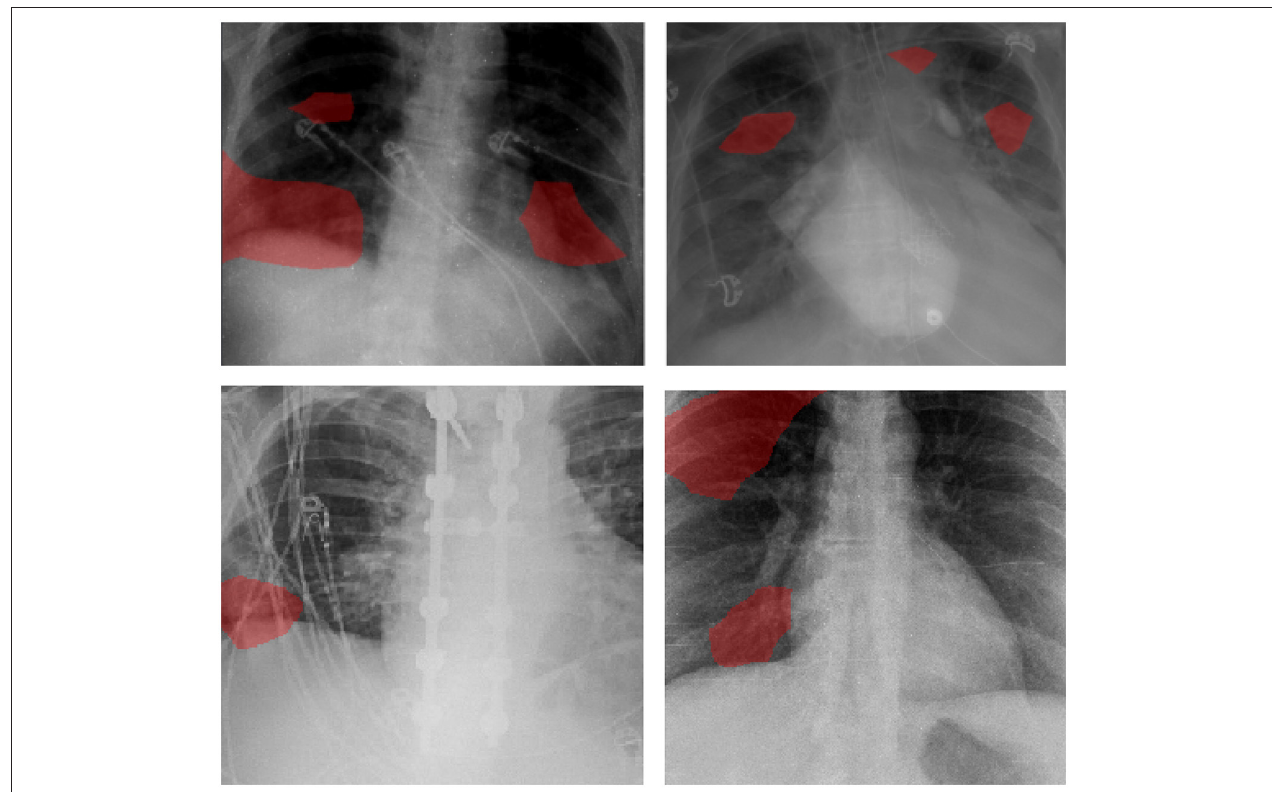
FIGURE 6 | Examples of patient cases and the associated critical factors (highlighted in red) as identified by GSInquire (59) during explainability-driven performance validation as what drove the decision-making behavior of COVID-Net CXR-2. Radiologist analysis was conducted on (top-left) Case 1 and (top-right) Case 2. Radiologist validation showed that several of the critical factors identified are consistent with radiologist